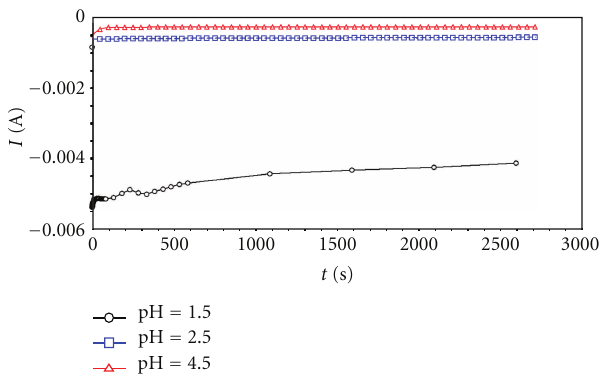
Figure 2: Chronoamperometry curves of the formation of Cu-In- S compounds from solution containing 5 mL of 0.1 M CuCl 2 , 5 mL 0.1 of M InCl 3 , and 150 of mL 0.1 M NaS 2 O 3 at − 1.0 V at di ff erent